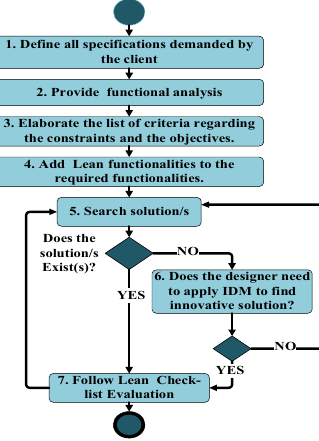
Figure 2. Steps of Lean-System-Design